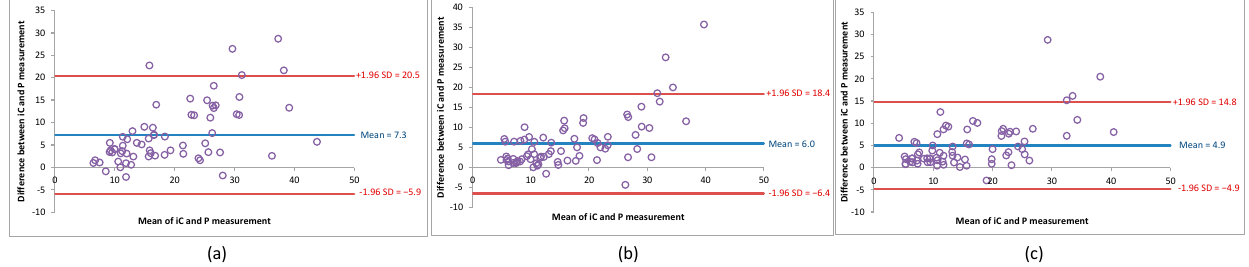
Figure 3. Difference between the measurement with iCare and Perkins in the form of Bland–Altman plot at the different time points for all children ( a ) T1, ( b ) T2, ( c ) T3. Abbreviation: IC: iCare; P: Perkins.